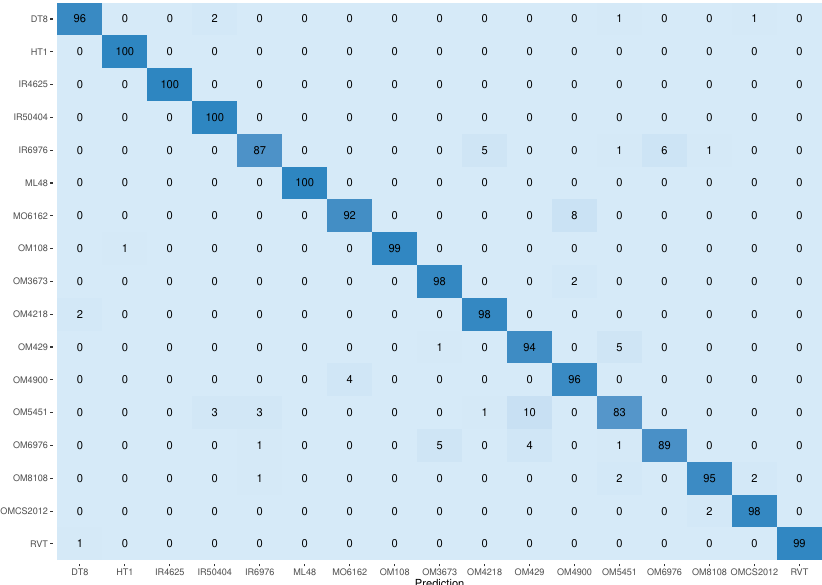
Figure 6. The confusion matrix from classification of the 17 rice